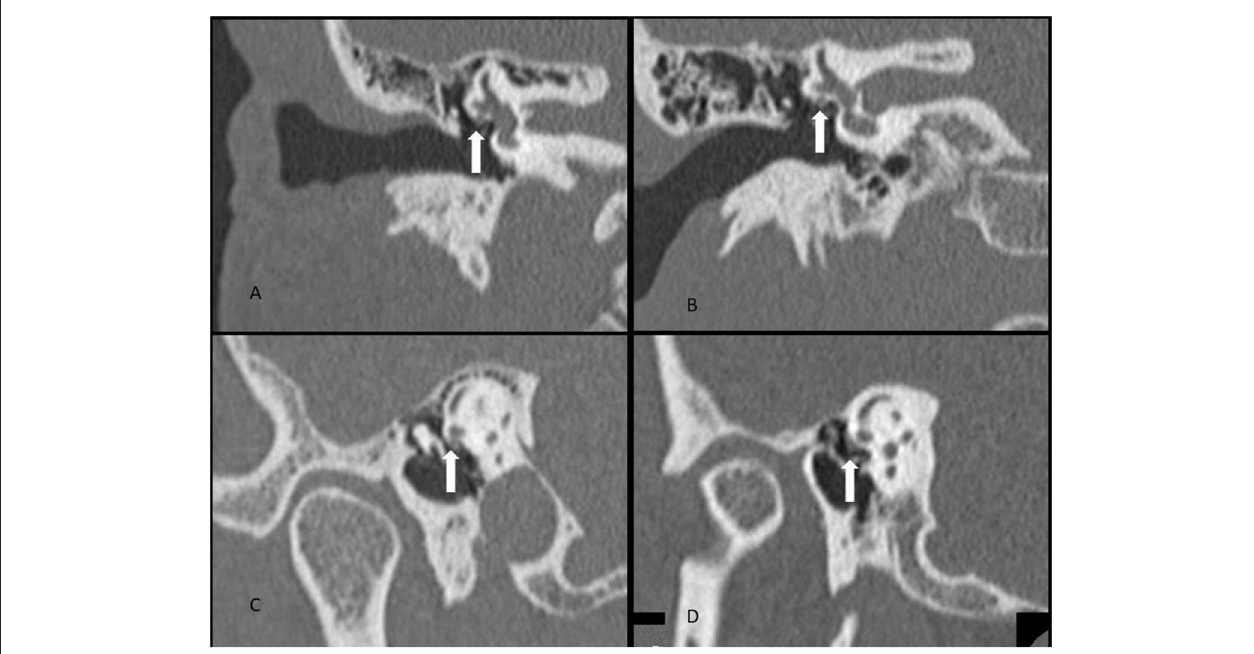
FIGURE 1 | CT scan demonstrating (A) HSC-FND on coronal imaging, (B) normal HSC and facial nerve anatomy on coronal imaging, (C) HSC-FND on Poschl imaging, and (D) normal HSC and facial canal on Poschl imaging.